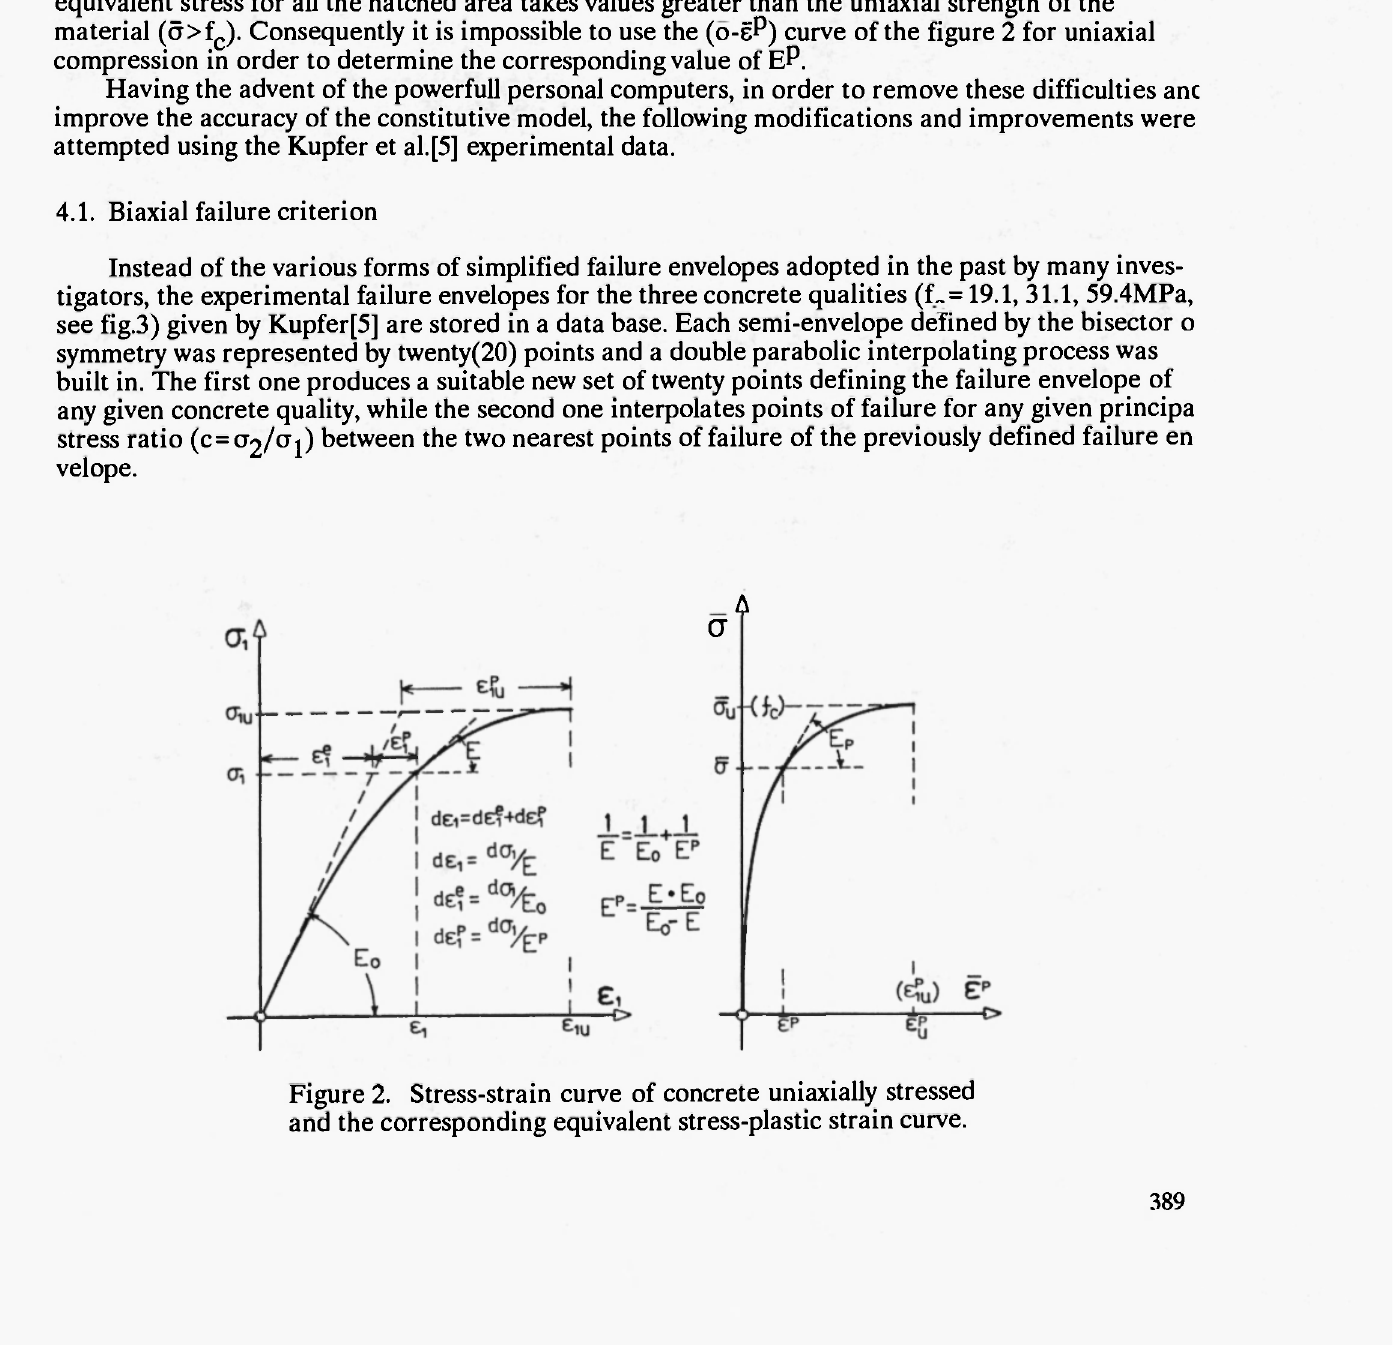
Figure 2. Stress-strain curve of concrete uniaxially stressed and the corresponding equivalent stress-plastic strain